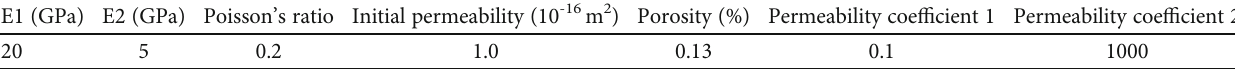
Figure 10: Distributions of the principal stress and hydraulic pressure. Table 3: Related seepage